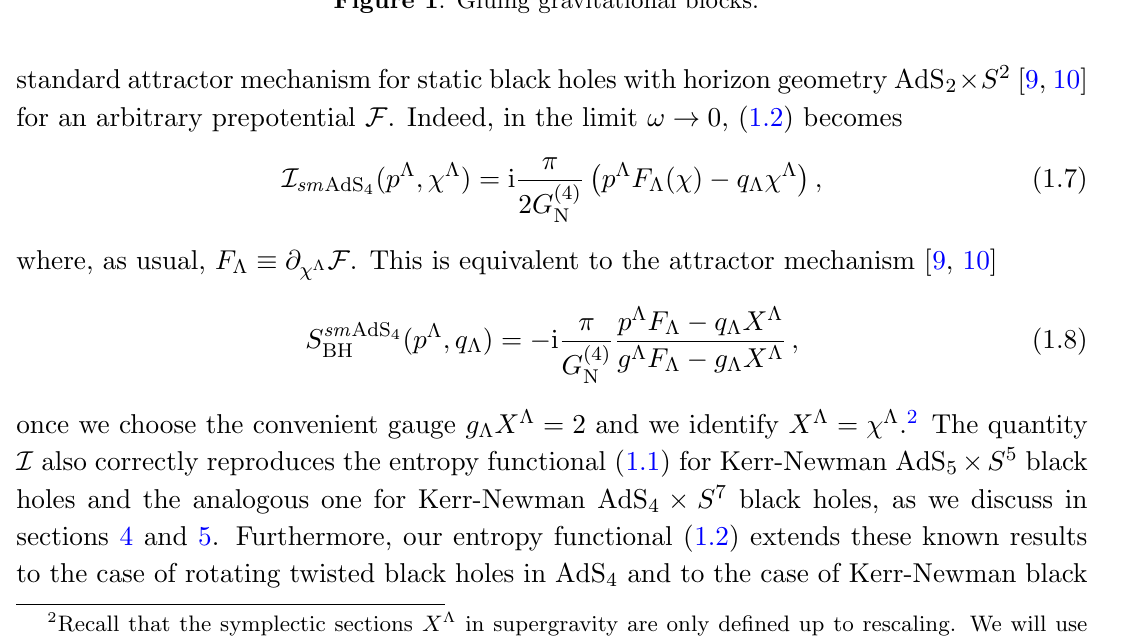
Figure 1 . Gluing gravitational